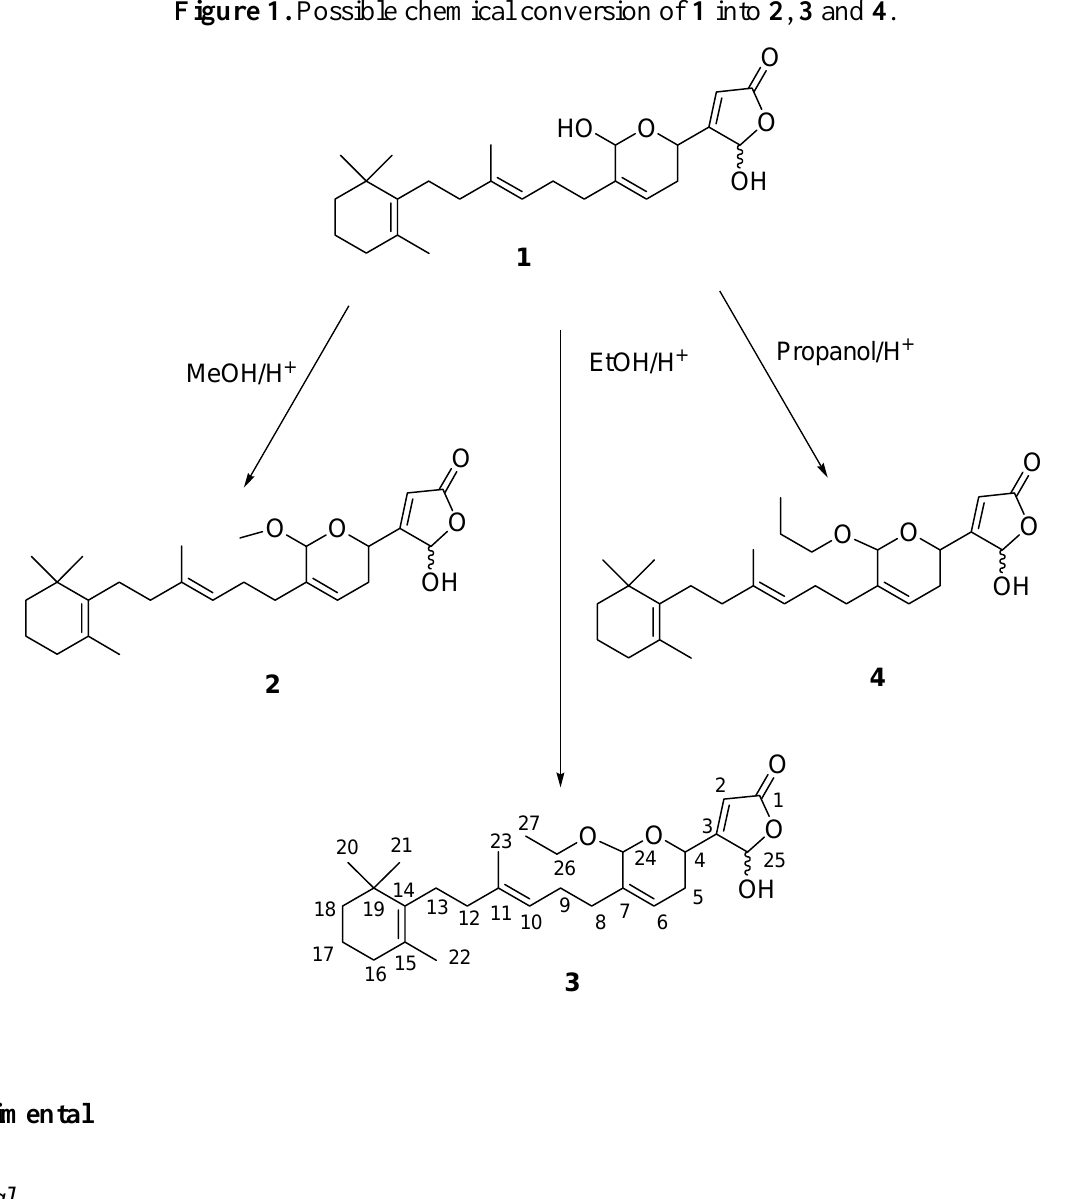
Figure 1. Possible chemical conversion of 1 into 2 , 3 and 4